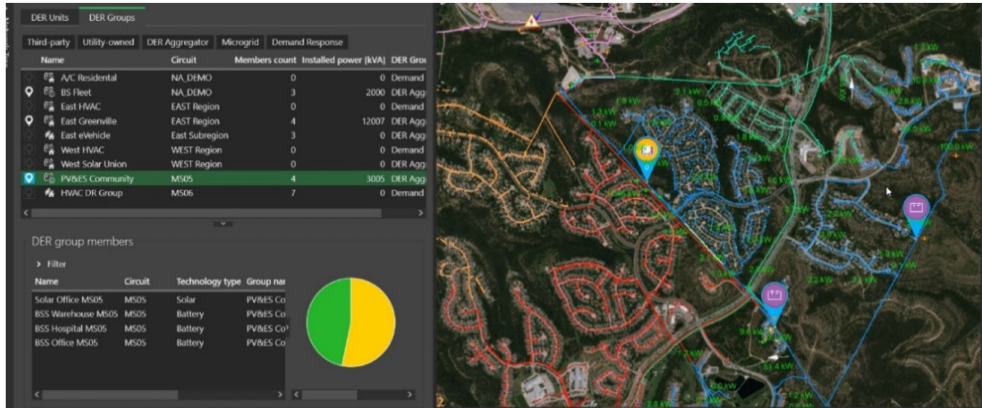
Figure 3. Distribution network state observed through the utility